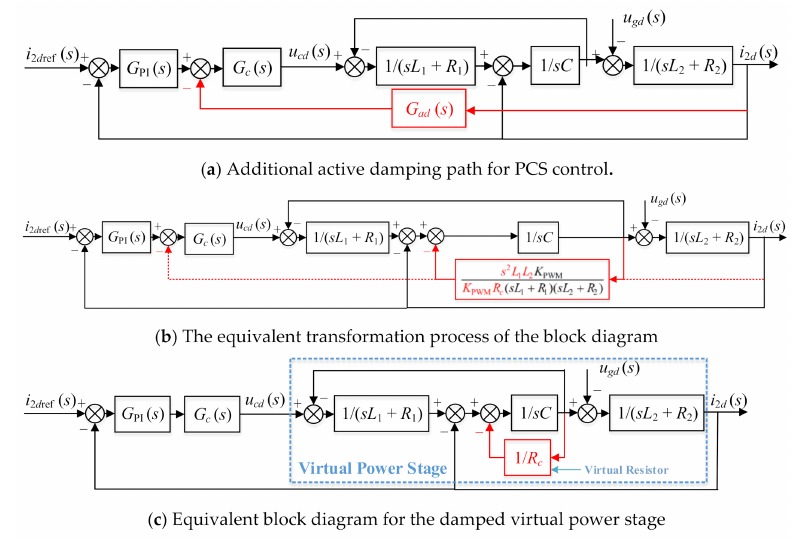
Figure 3. Block diagram for active damping method by applying virtual resistor in parallel with the filter capacitor.